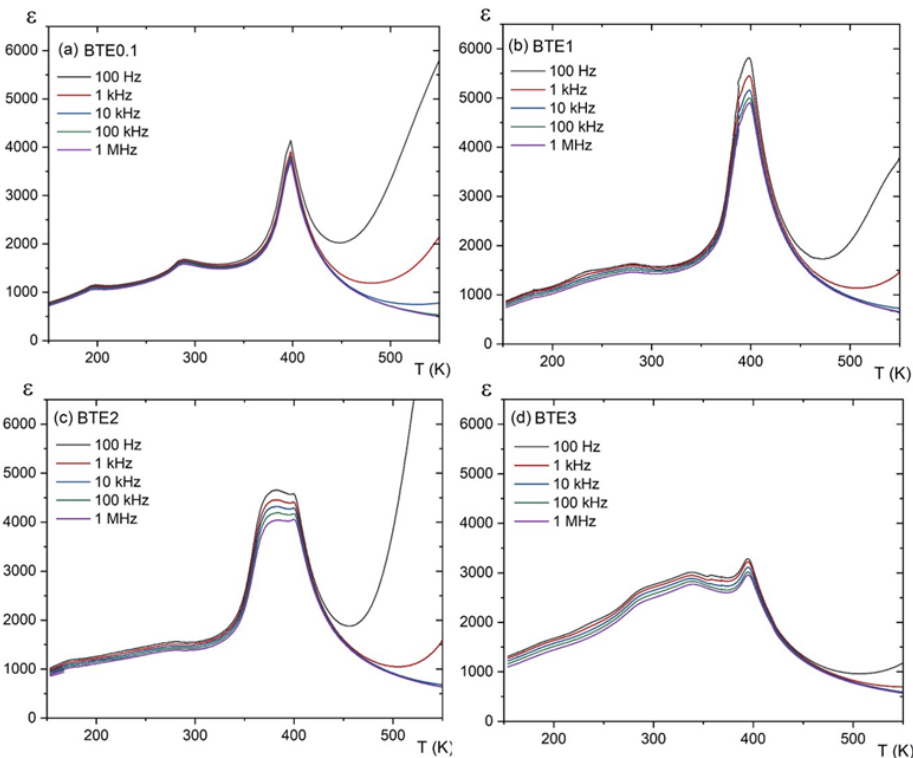
problem of local structural heterogeneity induced by aliovalent Eu 3+ doping was also ob- Figure 5. Temperature dependences of the dielectric constant for BTEx ceramics: ( a ) BET0.1, ( b ) BTE1, ( c ) BTE2, and ( d ) BTE3.